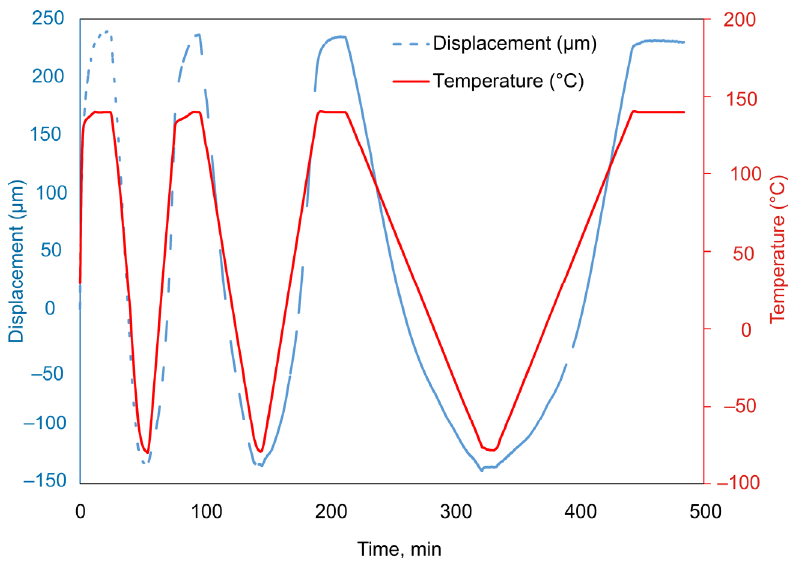
Figure 11. Time dependence of the parameters recorded in experiment, for the DeSolite DS-2015 polymer specimen.